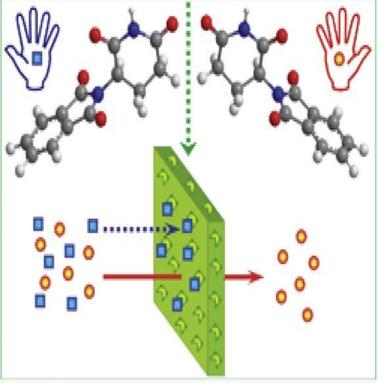
Schematic of chiral separation using membranes.